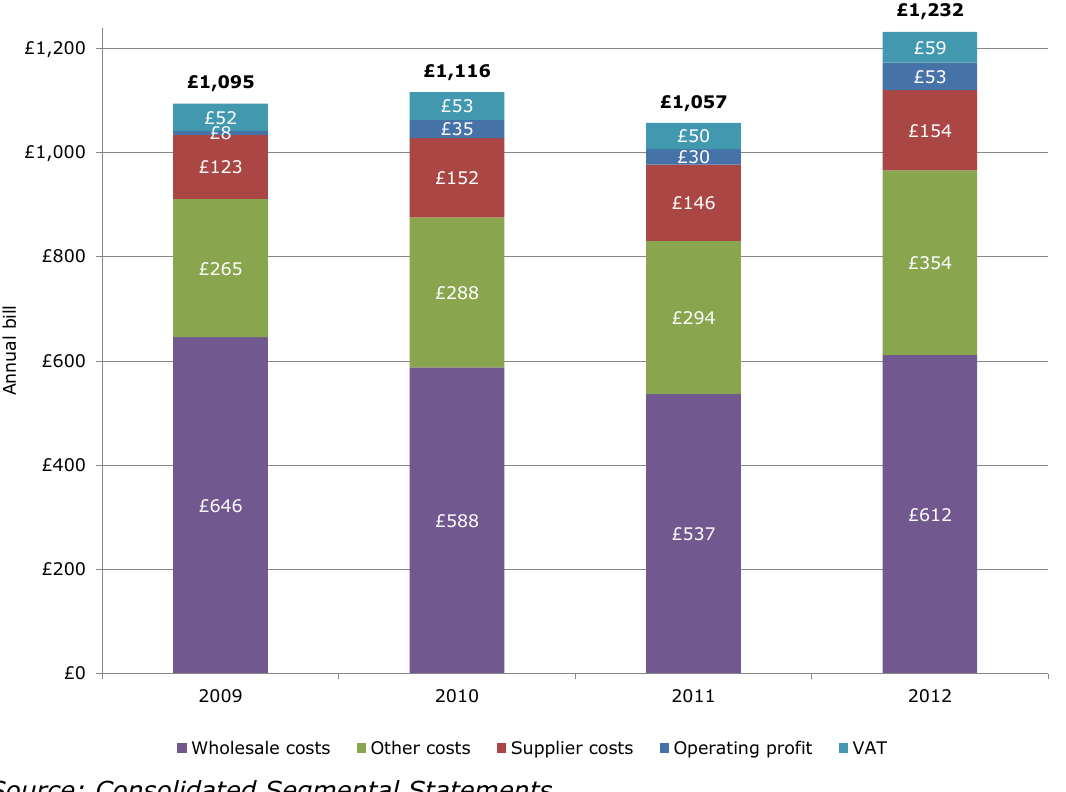
Figure 1: Average dual fuel 1 household bills